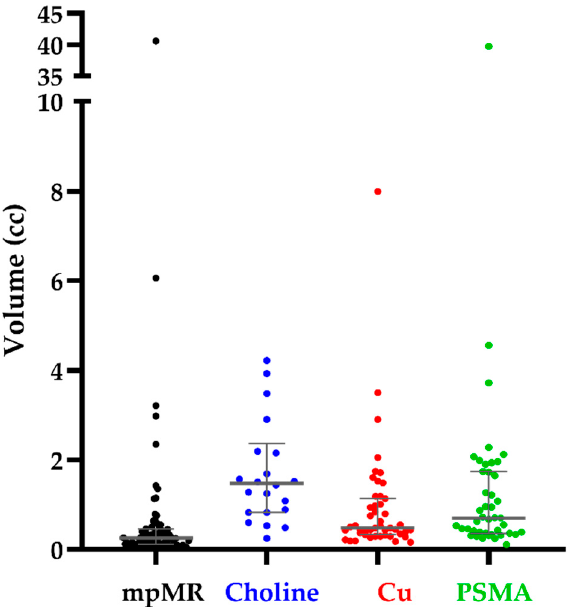
Figure 3. Individual volumetric data TP lesions at mpMR and PET/CT. Grey lines indicate the median values along with the interquartile range.